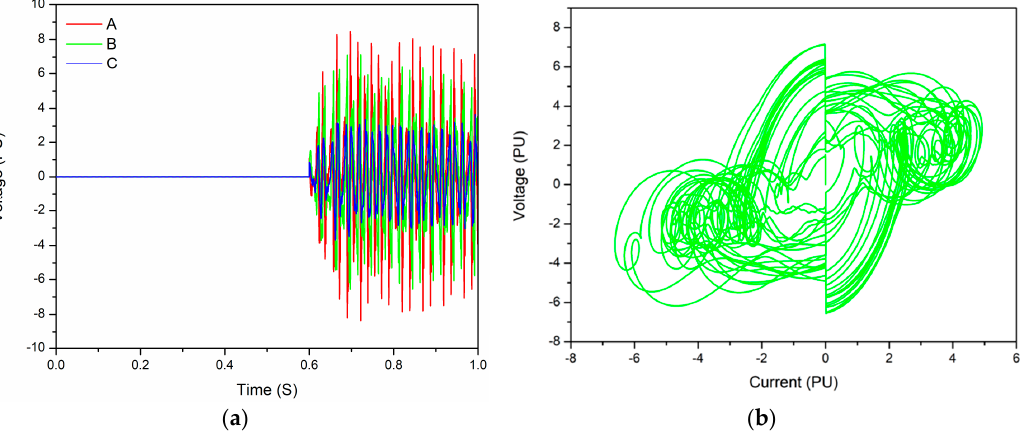
Figure 10. The ferroresonant results during energization at 0.6 secs on the WRIG wind turbine: ( a ) Voltage waveform showing highest overvoltage on phase A; ( b ) Phase plane diagram of phase B showing chaos.